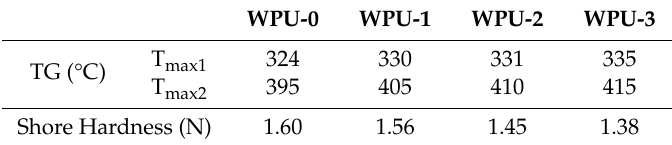
ff erent WPU films. Figure 6. The TG curve of different WPU films. Figure 6. The TG curve of di Table 3. Properties of WPU emulsions and